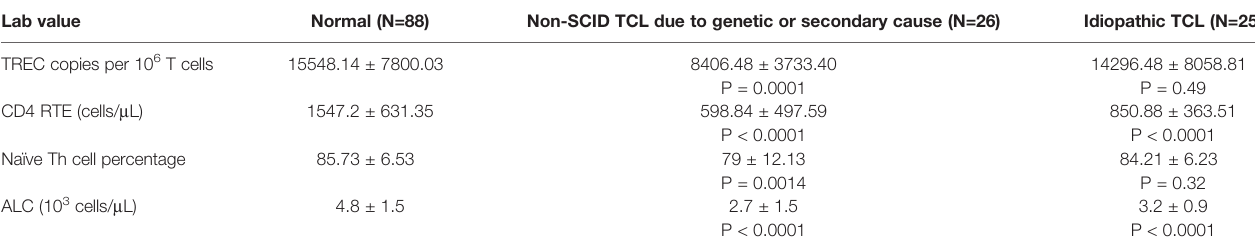
P-values re fl ect comparison with the normal T cell count